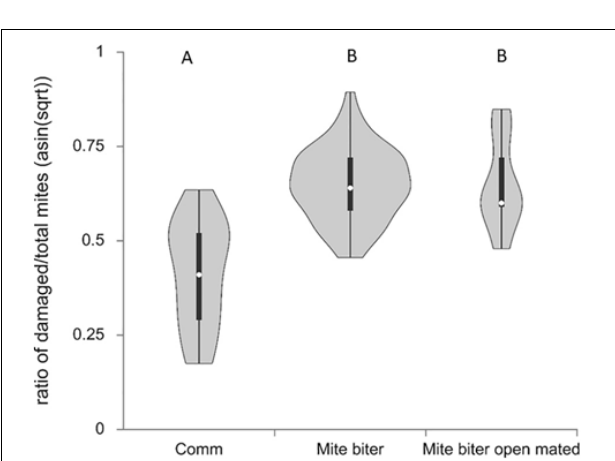
FIGURE 4 | Violin plots of the percentage of damaged mites identified in relation to total mites collected per colony among three groups, commercial colonies (Comm, N colony = 15, N mite = 172), Indiana mite-biter colonies (mite biter, N colony = 59, N mite = 1,201), and open-mated mite-biter colonies (open-mated mite biter, N colony = 7, N mite = 199). The one-way ANOVA suggested that one or more groups were significantly different, F (2,80) = 28.86, p = 4.16e - 10 . The Tukey honestly significant difference test indicated that the levels of mite-biting behavior were not significantly different between the mite-biter and open-mated mite-biter colonies, but both were significantly higher than the commercial colonies, Q = 10.63 and 6.72, p < 0.01.